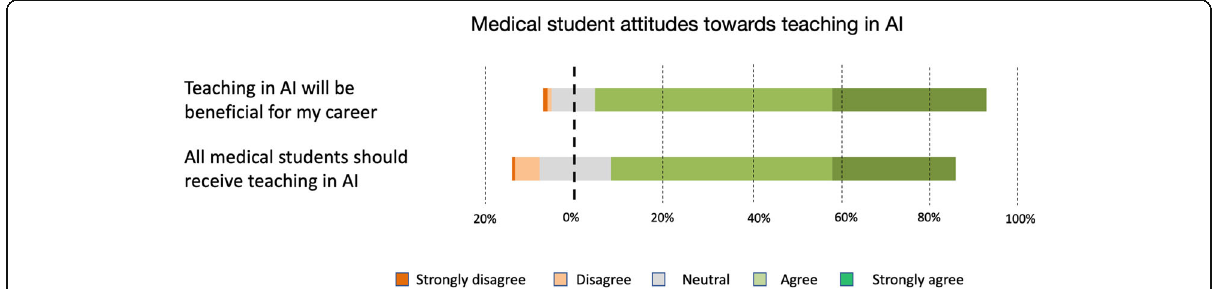
Fig. 3 Summary of medical student attitudes towards teaching on